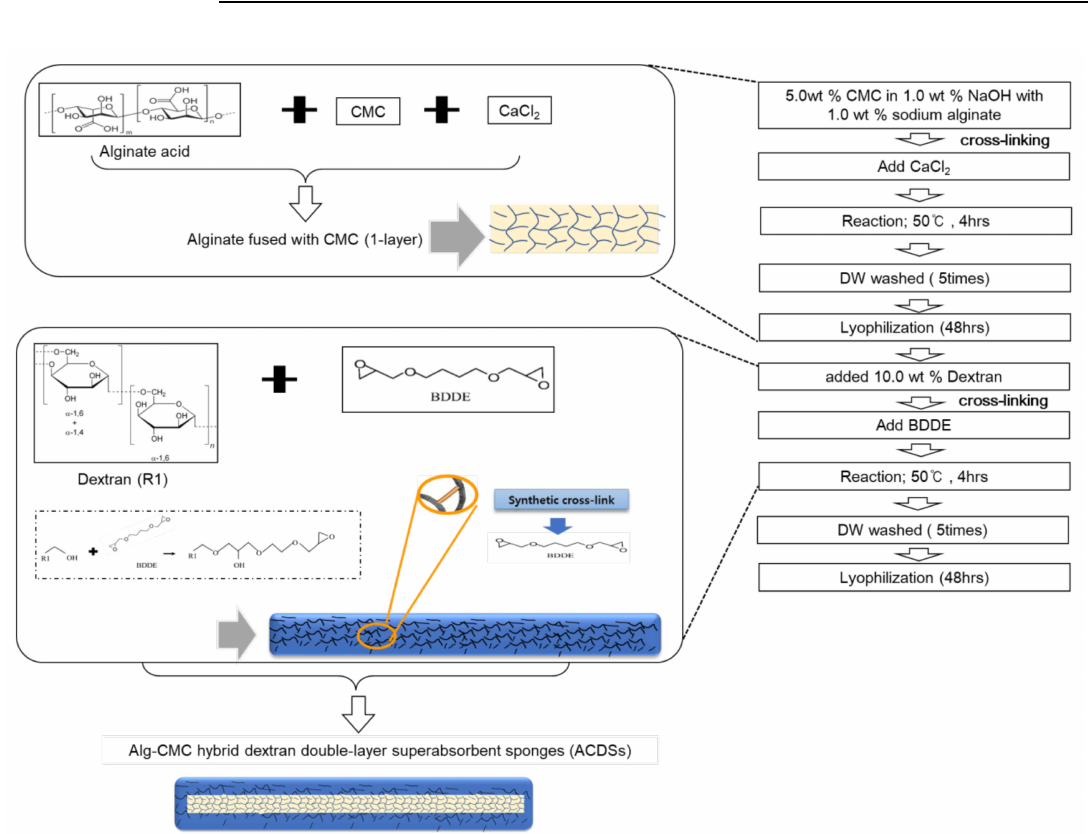
Figure 2. Schematic diagram showing the fabrication process of the Alg-CMC hybrid dextran double-layer superabsorbent sponges